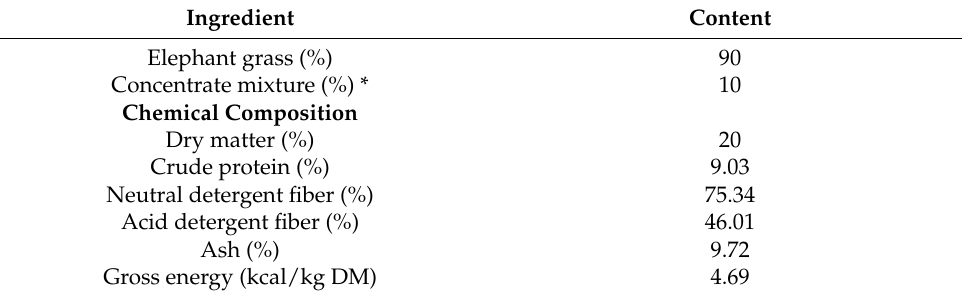
Table 1. Chemical composition of the substrate (DM basis).